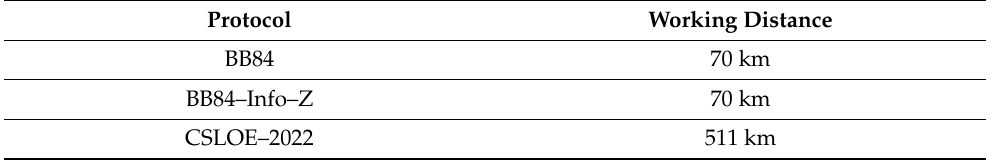
Table 3. Working distance of